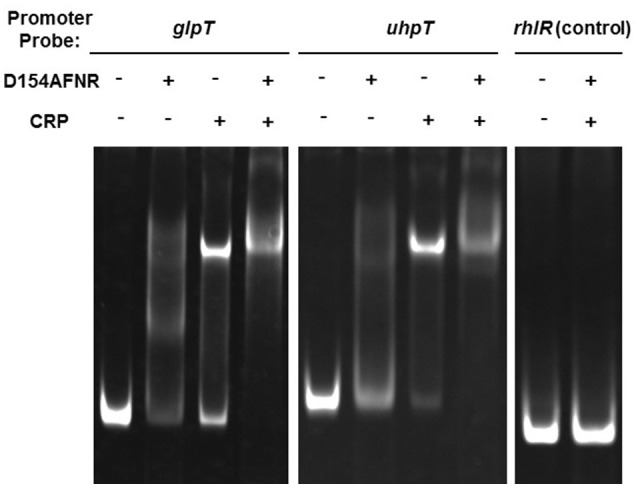
Gel-shift assay showing binding of CRP-cAMP and D154AFNR to the glpT and uhpT promoter. CRP and/or D154AFNR proteins (−CRP and -D154AFNR; no protein, +CRP; 1.2 pmol of the CRP protein, +D154AFNR; 10 pmol of the D154AFNR protein) were added to reaction mixtures containing 0.3 pmol of DNA probe. DNA upstream of rhlR was used as a non-binding (negative) control.